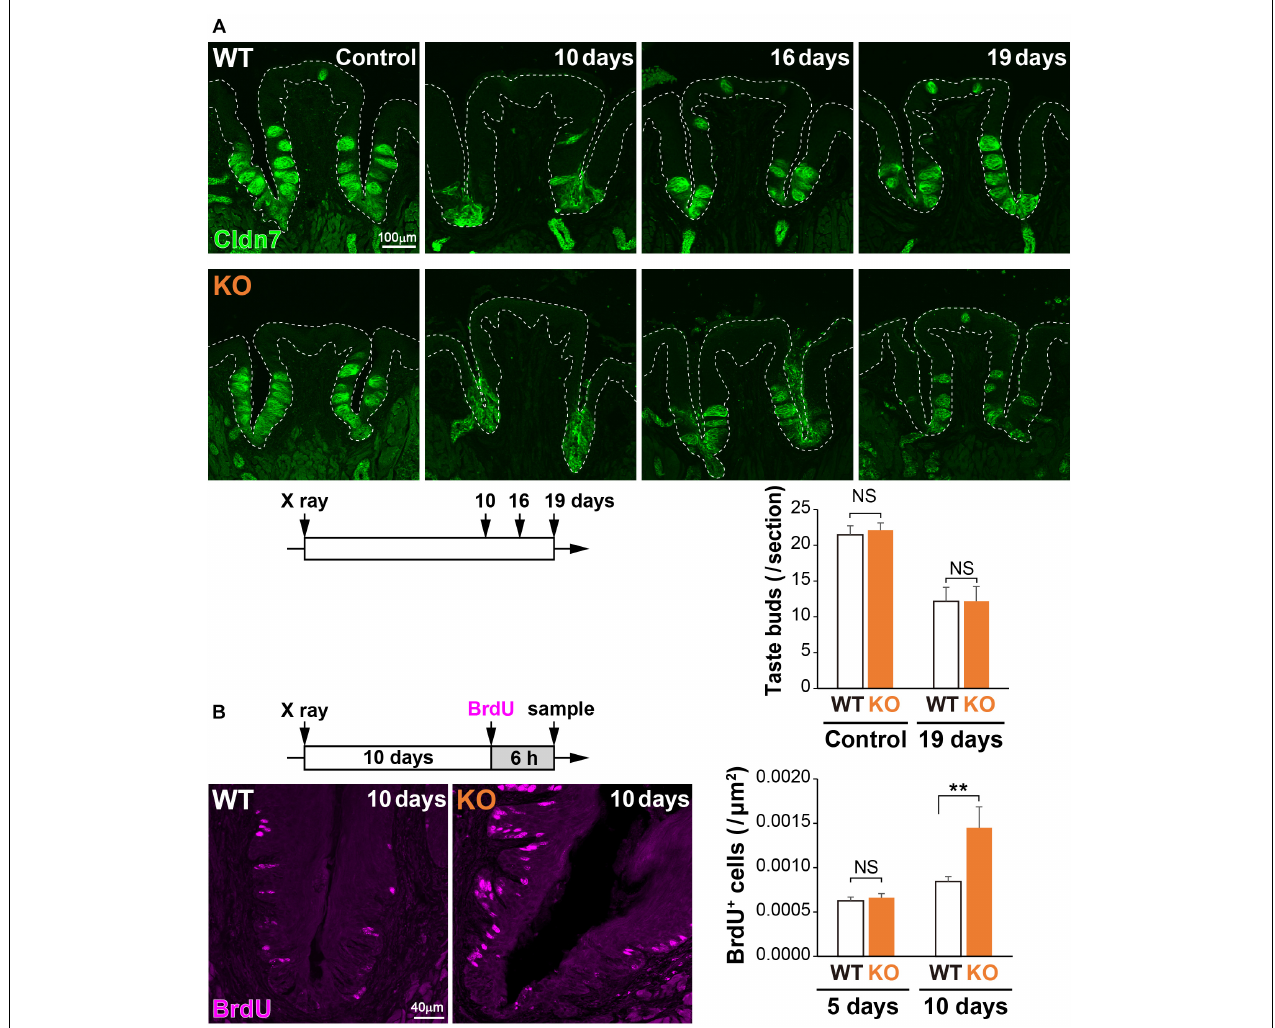
FIGURE 6 | Cell proliferation in the CVP is increased more in 5T4 -KO mice than in WT mice after X-ray irradiation. ( A , Top) The CVPs of WT and 5T4 -KO mice at 10, 16, and 19 days after X-ray irradiation were sectioned and subjected to IHC with an anti-Cldn7 antibody (a marker of TBCs; green). Images are Z-stack projections of seven sections (0.56 µ m/slice). Scale bars, 100 µ m. White dotted lines indicate the area of the lingual epithelium. (Bottom) The number of taste buds is expressed as the mean ± SEM (NS: not significant between WT and 5T4 -KO mice at 0 and 19 days, respectively; two-way ANOVA following the Bonferroni post hoc test; for control, n = 12 sections from six WT mice and 8 sections from four 5T4 -KO mice; for 19 days, n = 6 sections from three WT mice and n = 5 sections from three 5T4 -KO mice). ( B , Left) Cell proliferation in the CVPs of WT and 5T4- KO mice at 10 days after irradiation. WT and 5T4 -KO mice were intraperitoneally injected with BrdU. Six hours after BrdU injection, cells in the CVP were immunostained with an anti-BrdU antibody (magenta). Images are Z-stack projections of five sections (0.56 µ m/slice). Scale bars, 40 µ m. (Right) Numbers of BrdU + cells are expressed as the mean ± SEM [NS, not significant ( p = 0.7042) and ∗∗ p < 0.001 between WT and 5T4 -KO mice at 5 and 10 days, respectively; two-way ANOVA following the Bonferroni post hoc test; for 5 days, n = 23 sections from eight WT mice and eight 5T4 -KO mice; for 10 days, n = 23 sections from eight WT mice and n = 8 sections from three 5T4 -KO mice].